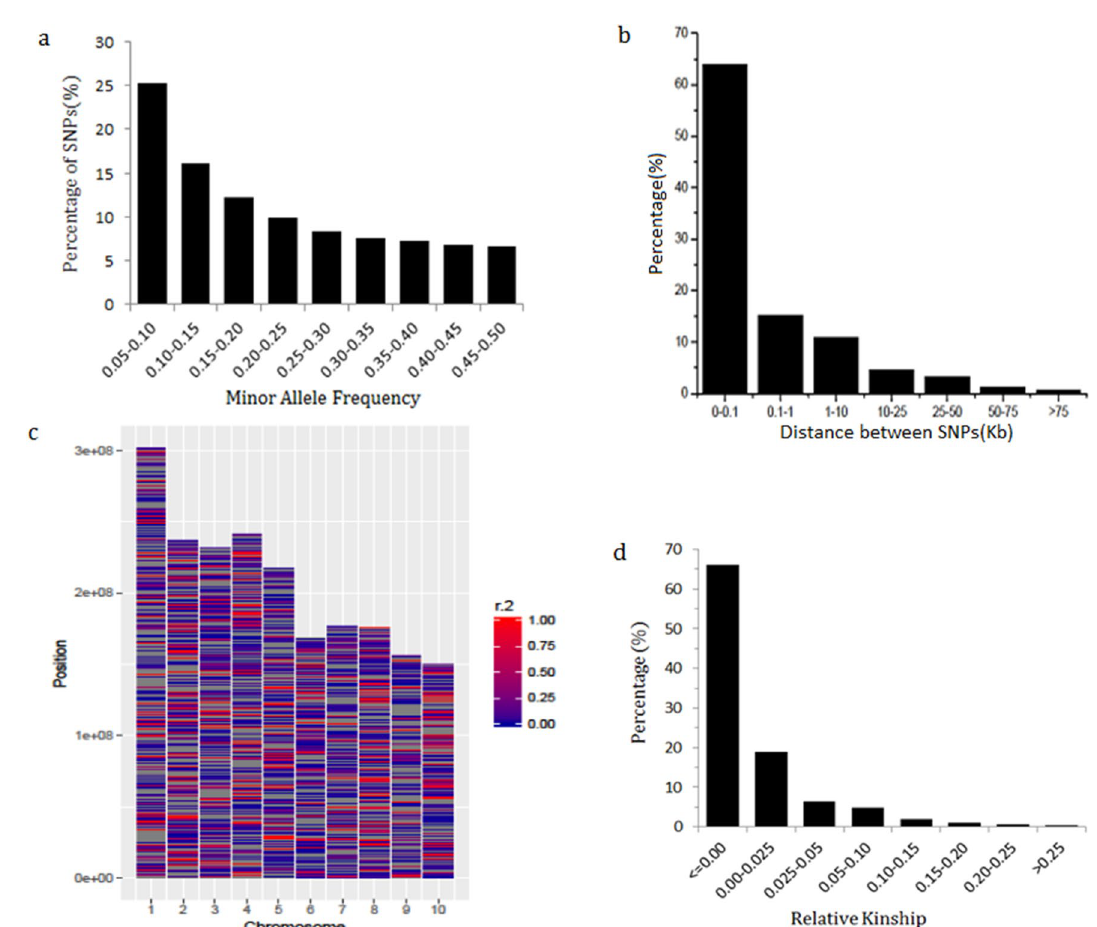
Figure 2. The molecular characteristics of maize genomes. ( a ) Minor allele frequency distribution; ( b ) Physical distance between adjacent SNP loci; ( c ) LD pattern of SNP loci along each of the 10 chromosomes; ( d ) The Relative kinship of 490